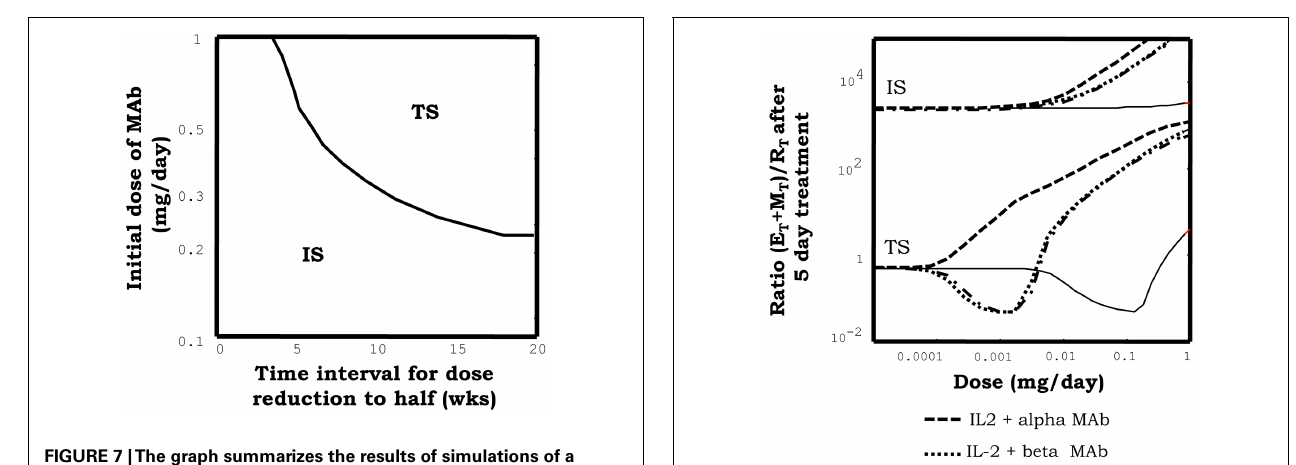
FIGURE 7 |The graph summarizes the results of simulations of a model system set initially to the IS and then perturbed with, an initial dose of the face beta mAb, which is periodically reduced to the half at the indicated time ( x axis) .The curve indicates the minimal value of the initial mAb dose required to induce tolerance (taking the system into the tolerant steady state) with the applied treatment. FIGURE 8 | Effect of injections for five days of the indicated doses of